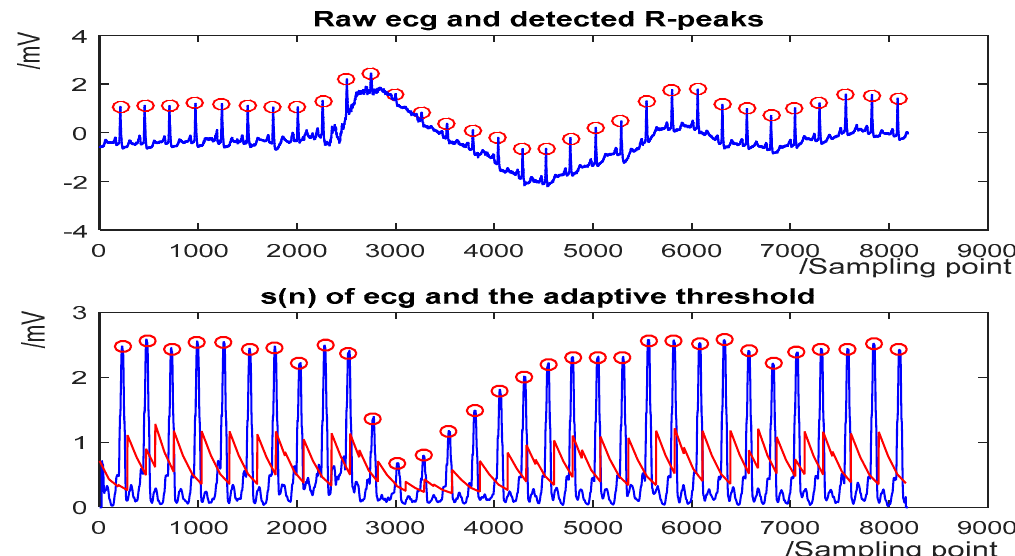
Figure 7. The QRS detection result of record 105 in the MIT-BIH Arrhythmia Database with baseline wander. ( Top ) the original ECG and detected R-peaks (red circle). ( Bottom ) s(n) in record 105 and the threshold (red line).